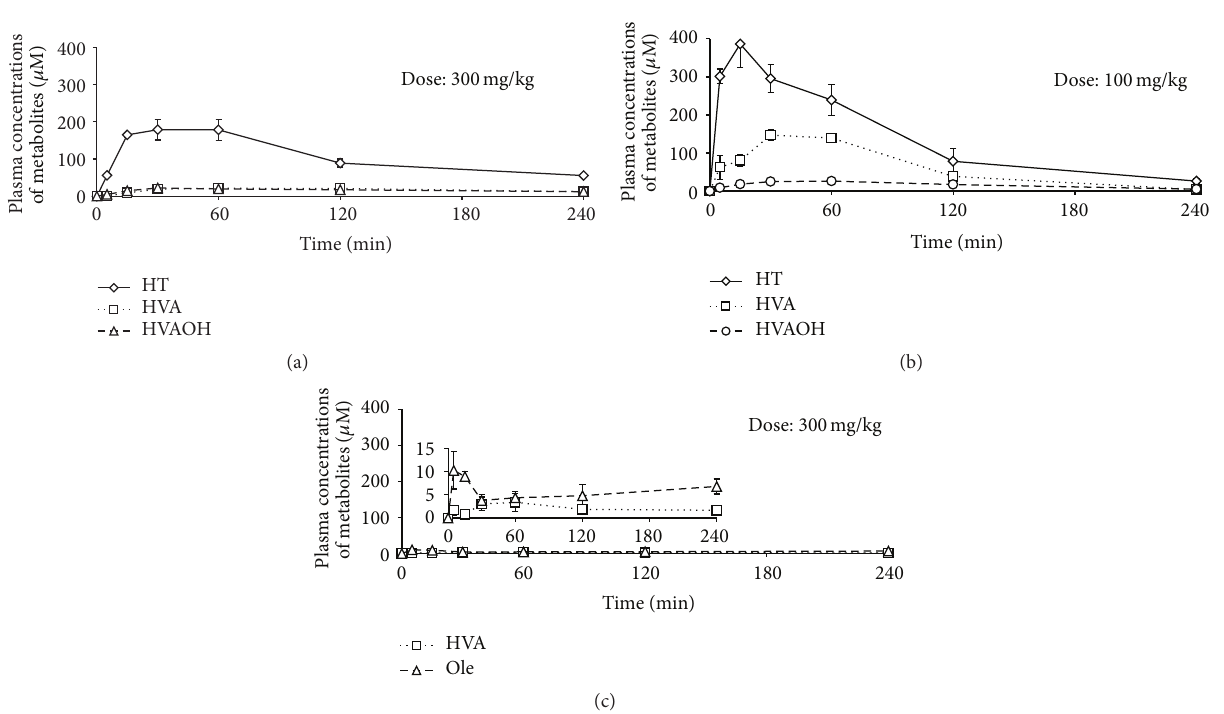
Figure 1: Metabolites from 3,4-DHPEA-EDA (a), hydroxytyrosol (b), and oleuropein (c) in plasma from the portal vein over time after oral administration (300 mg/kg for 3,4-DHPEA-EDA, 100mg/kg for HT, and 300 mg/kg for Ole). Values of means and SEM are from measurements performed in triplicate. Sampling times are described in the text. HT: hydroxytyrosol, Ole: oleuropein, HVA: homovanillic acid, and HVAOH: homovanillyl